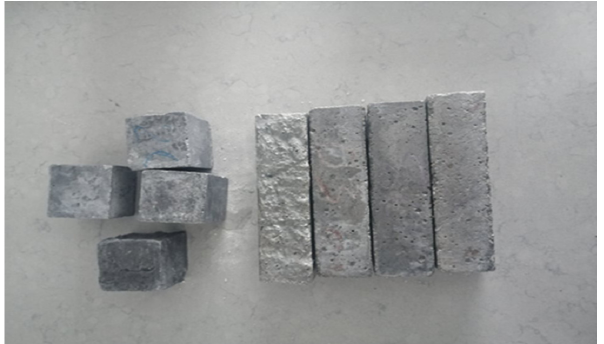
Figure 2. Carbon-fiber-enriched bottom ash composites.